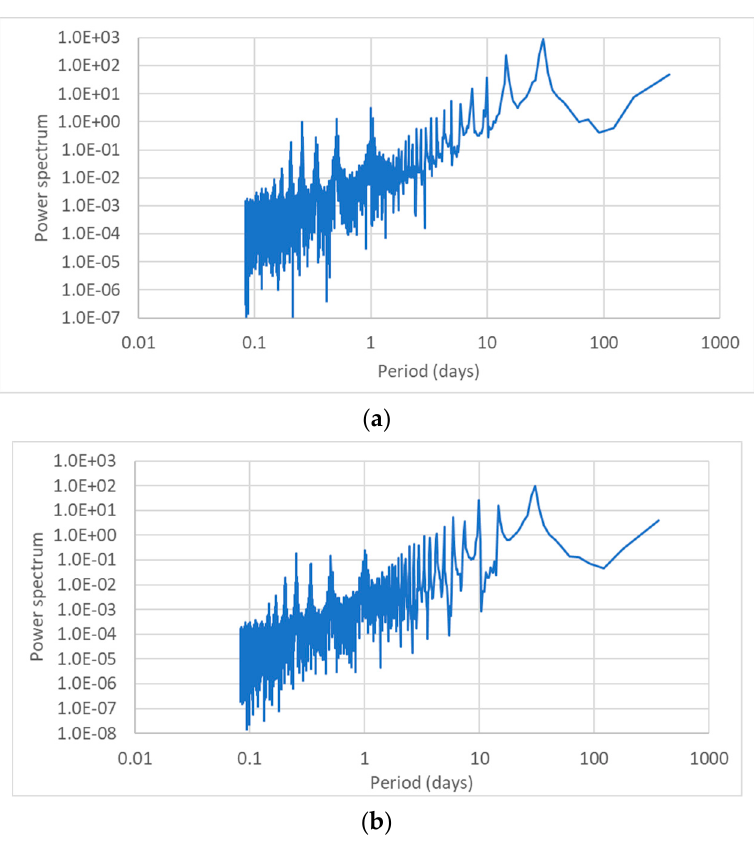
Figure 8. The power spectrum of time series of the global mean TOA OSR flux ( a ) and the global mean shortwave radiance ( b ) in the Moon-based view, in 2017. The period is presented in days.